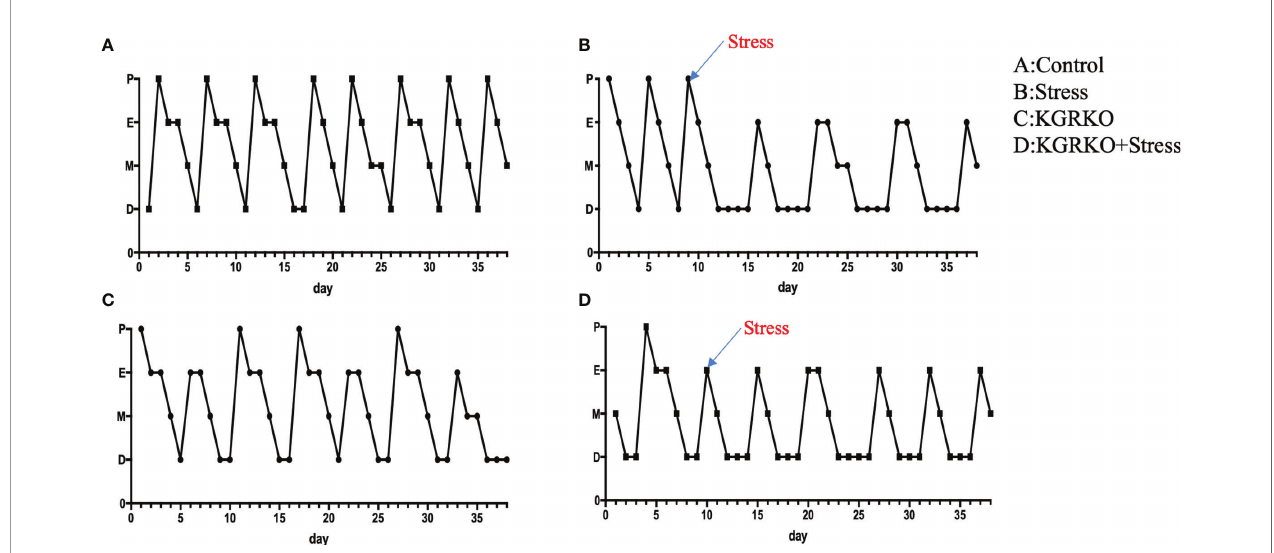
FIGURE 2 | The effect of chronic restraint stress on the estrous cycle offemale KGRKO mice. Estrous cycle included 4 states, P, Proestrus; E, Estrus; M, Metestrus; D, Diestrus. (A) control group, (B) restraint stress group. (C) KGRKO group, Kisspeptin neuron-speci fi c GR knockout mice group. (D) KGRKO+ restraint stress group, Kisspeptin neuron-speci fi c GR knockout mice restraint stress group.